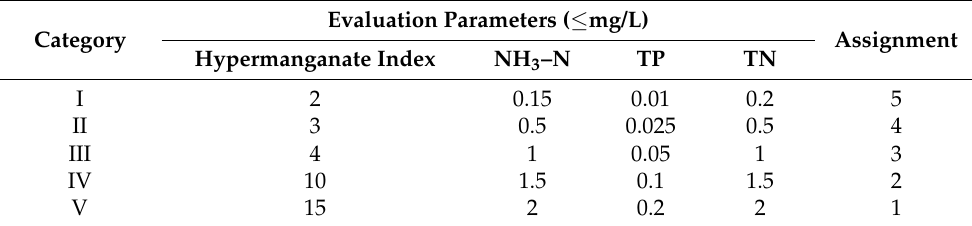
Table 1. Water quality chemical index classification evaluation standard.